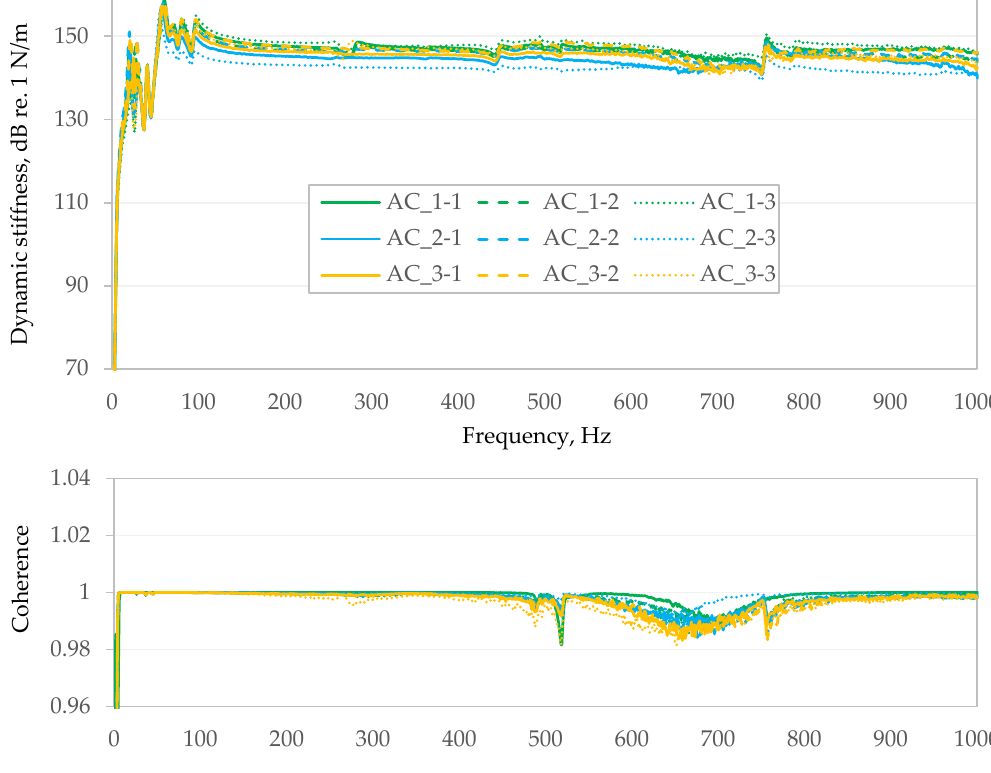
Figure 6. Dynamic sti ff ness ( top ) and coherence ( bottom ) of the AC